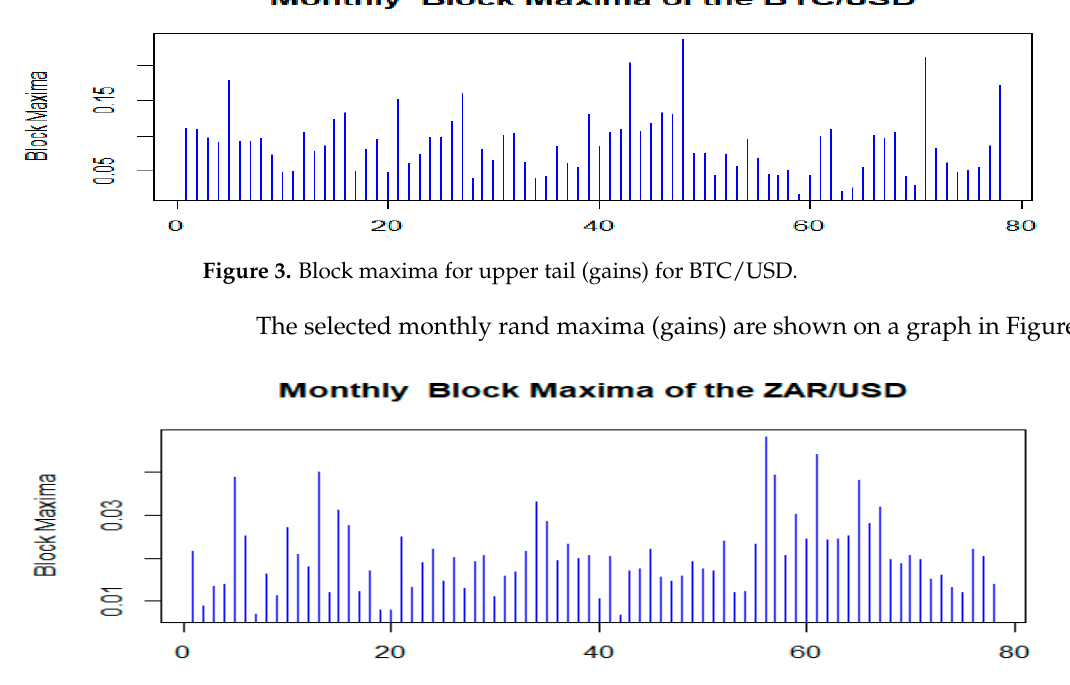
Figure 4. Block maxima for upper tail (gains) for ZAR/USD.